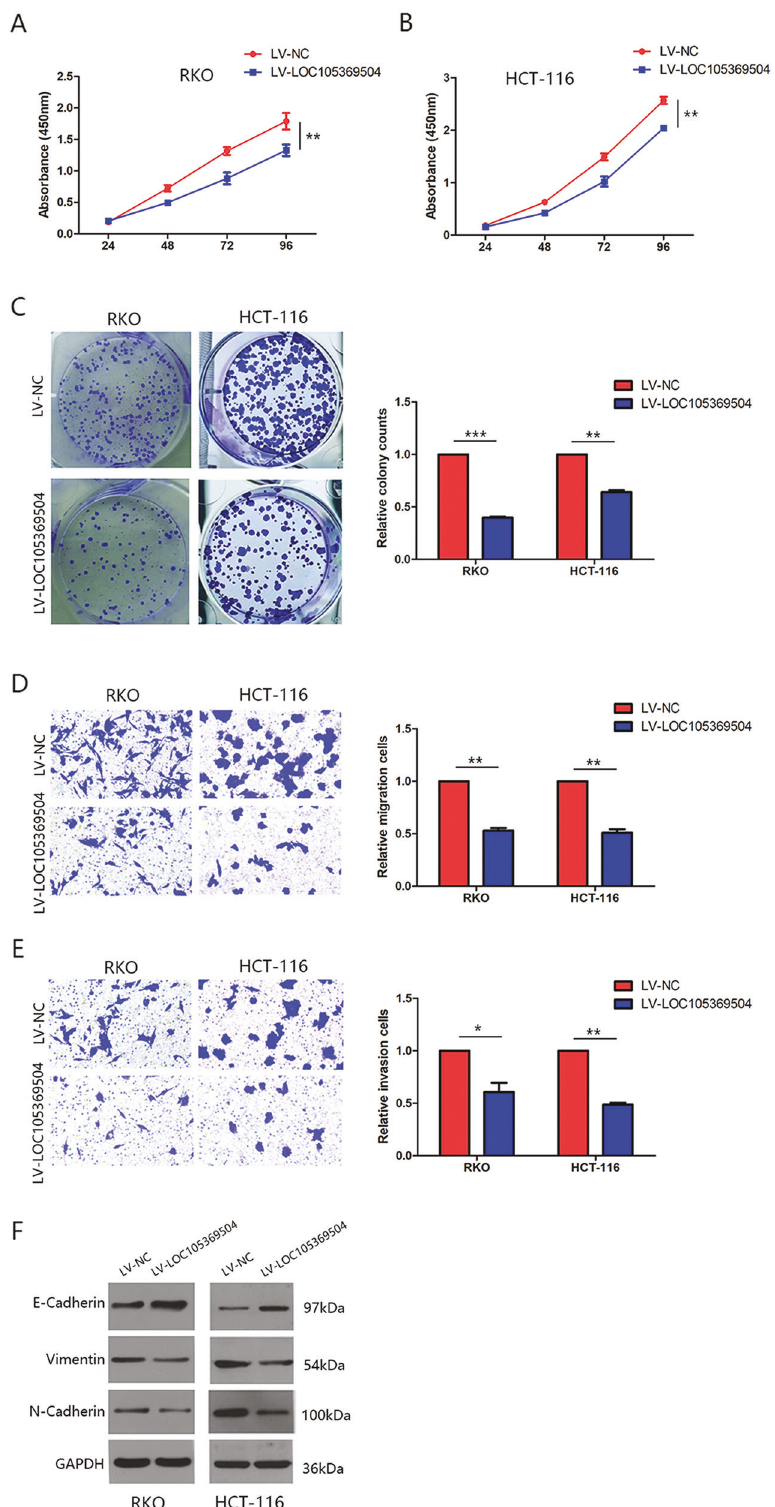
Fig. 2 LOC105369504 suppresses CRC cell proliferation and metastasis mediated with EMT in vitro. A , B The effect of LOC105369504 on proliferation in RKO and HCT-116 cells transfected by LV-NC or LV-LOC105369504 through the CCK-8 assay. C Colony formation analyses for CRC cells after LOC105369504 was overexpressed. D , E Transwell analysis was applied for determining the CRC migration together with invasion after LOC105369504 was overexpressed. F Western blotting indicated increased epithelial marker expression and attenuated mesenchymal marker expression in the CRC cells transfected with LV-LOC105369504. All the data are expressed as the mean ± SD. * p < 0.05, ** p < 0.01, *** p < 0.001.